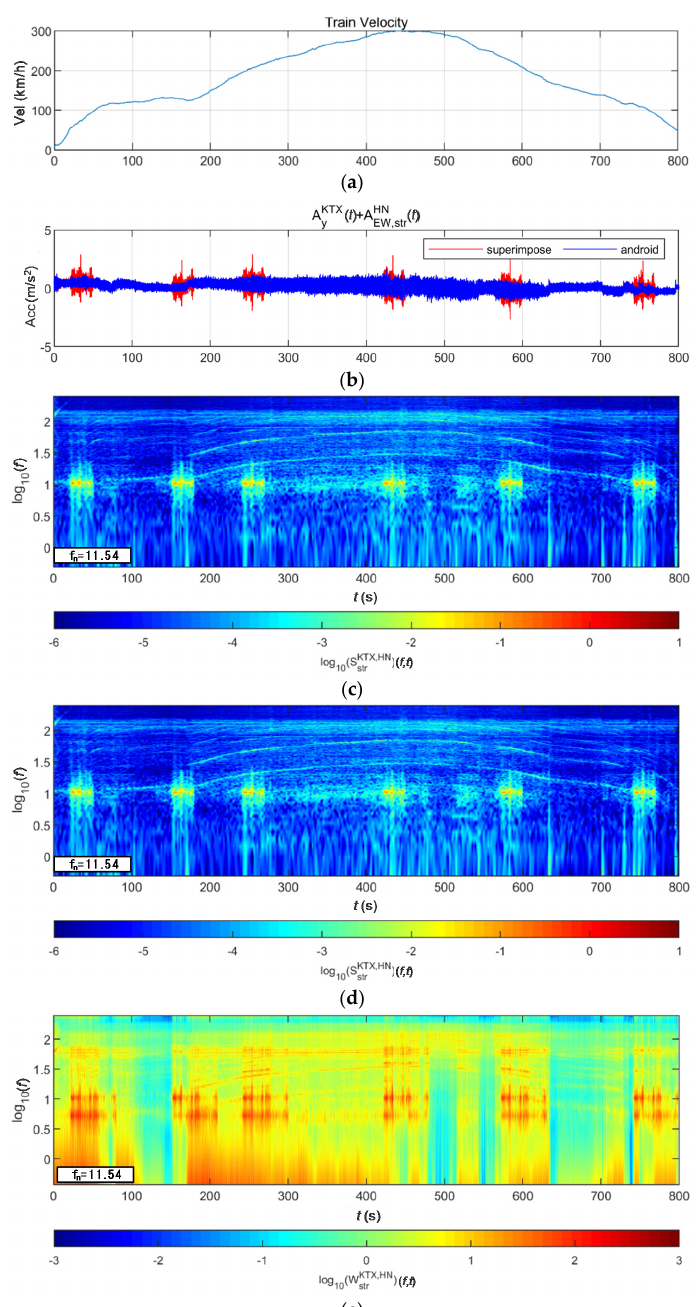
Figure 33. Combination of train data with BR2 bridge-response data from the Hachinohe earthquake (scaled to 2400-year return period): ( a ) velocity; ( b ) lateral acceleration time series; ( c ) STFT; ( d ) WT; ( e ) WVD.